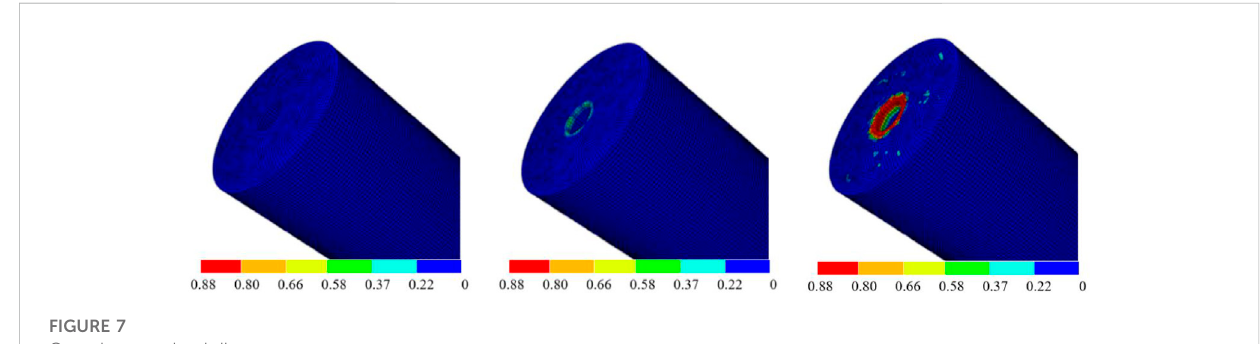
FIGURE 7 Core damage cloud diagram.